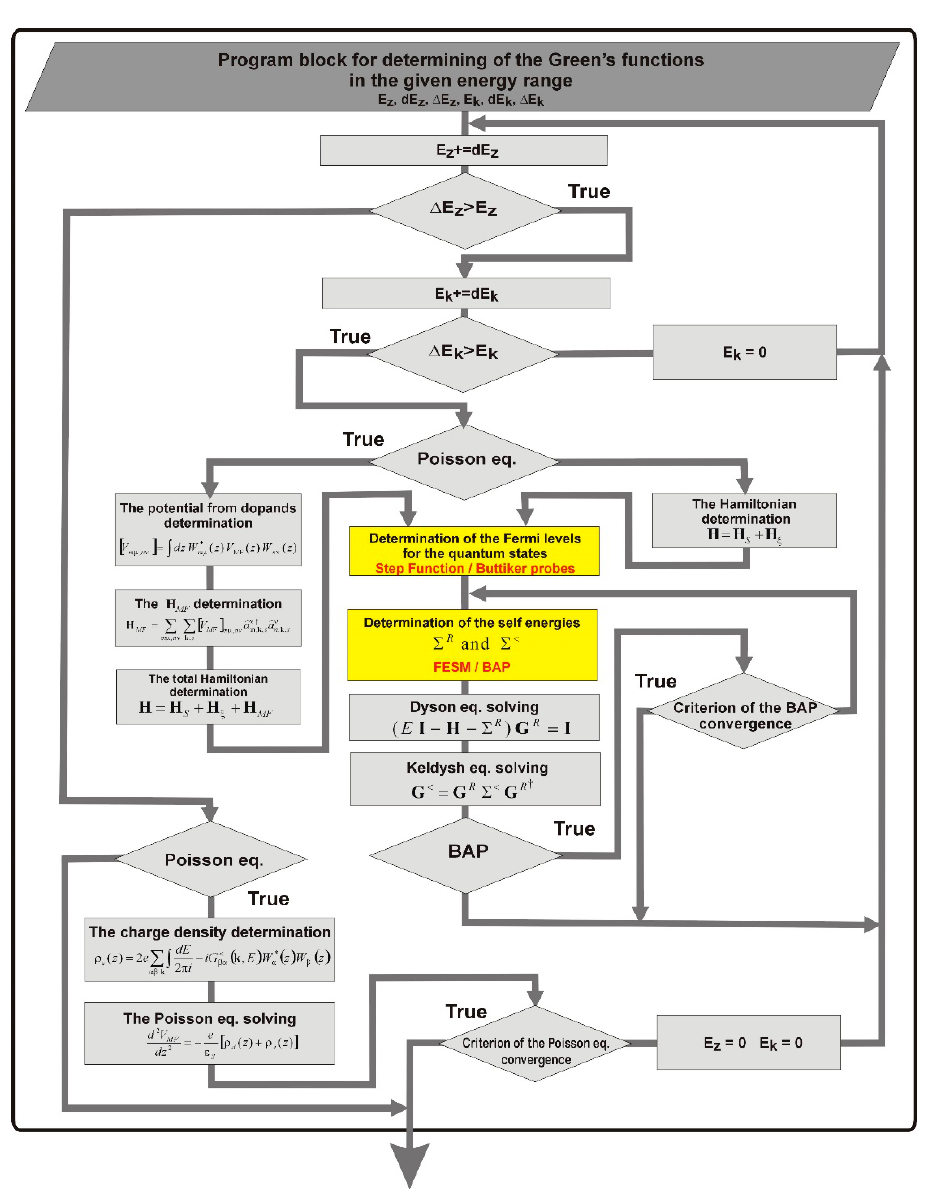
Figure 8. The detailed algorithm for determining the Green’s functions in the given energy range used in superlattice simulations with SLSim. The yellow colour indicates the blocks where the new approach for GF determination was used.